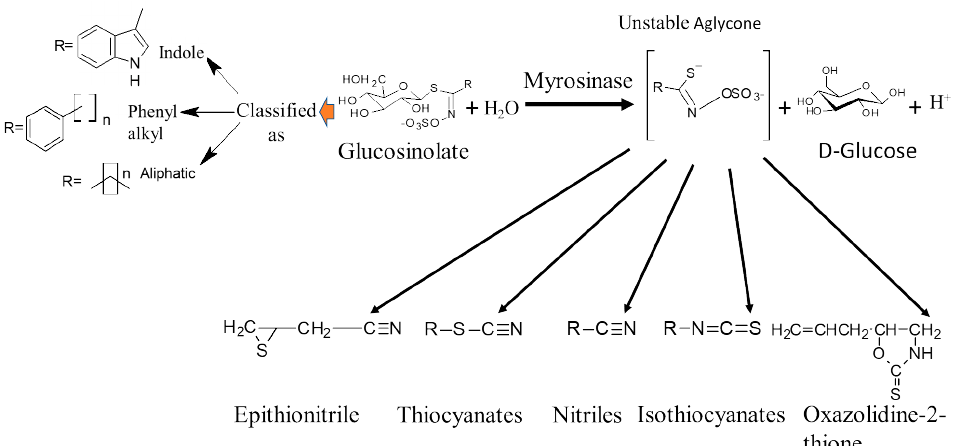
Fig. 1: The enzymatic hydrolysis products of glucosinolates modified from ( l aMbrix et al., 2001; h anSChen et al., 2014). The main glucosinolate side chain classifications (R) h anSChen et al., 2014; K opriVa and g igolaShVili , 2016).